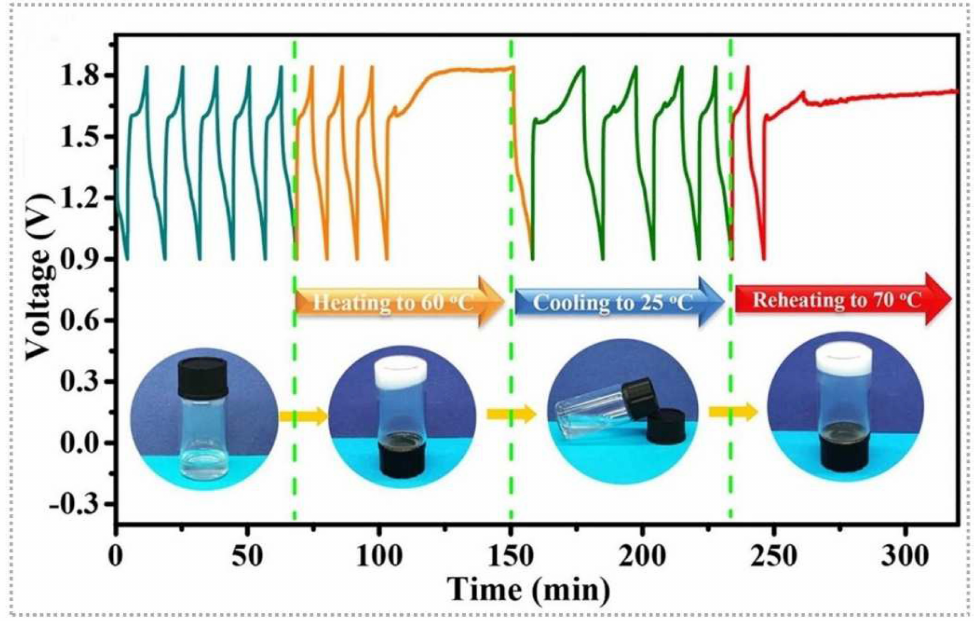
Figure 7. Charge-discharge cycles of the Zn/ α -MnO 2 battery with PNA sol-gel electrolyte at different temperatures, and the digital photos of reversible sol-gel transition. Adapted with permission from Ref. [55]. Copyright 2018, Science